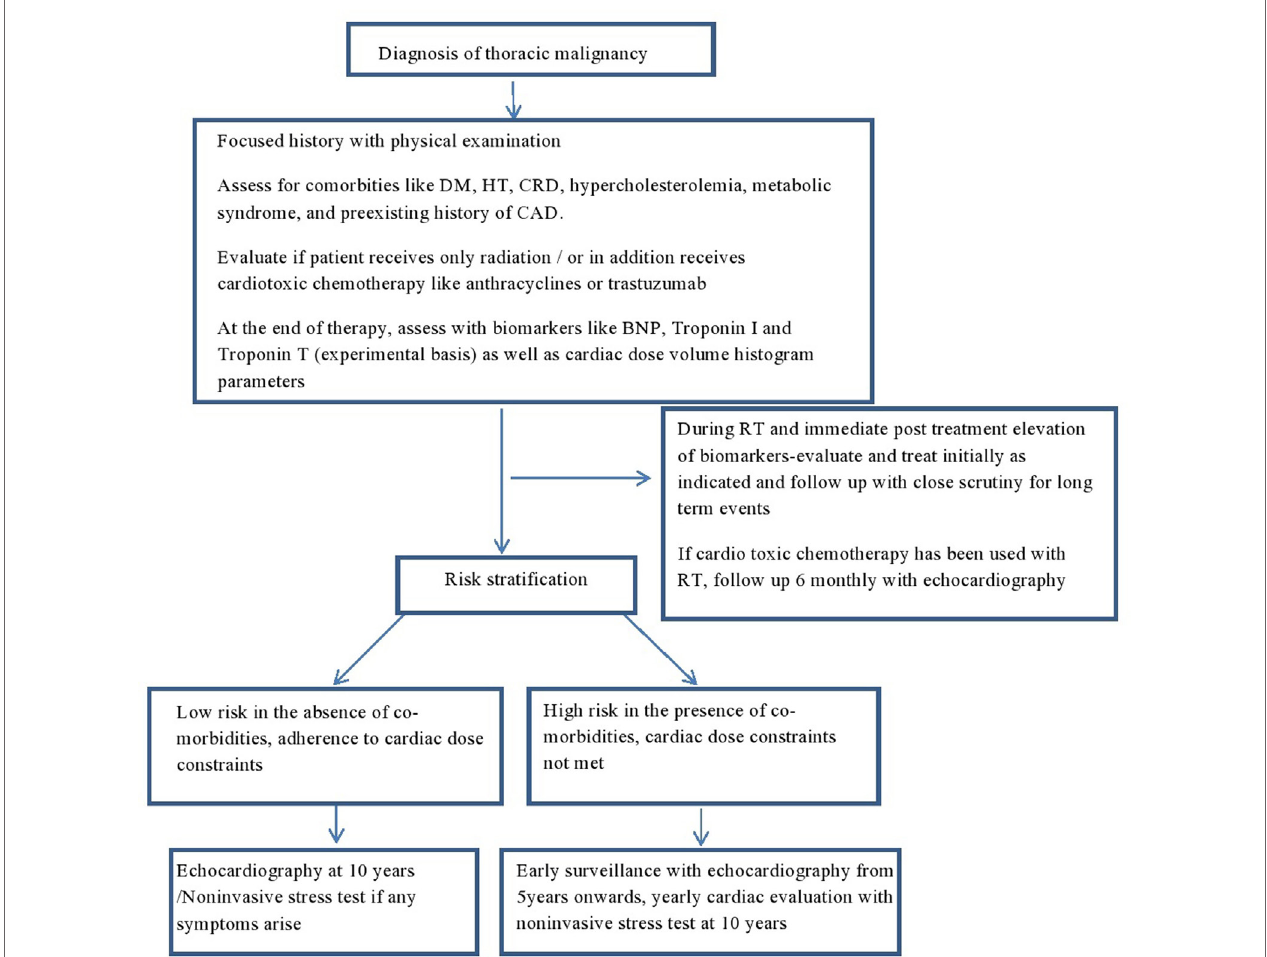
FigURe 2 | Proposed algorithm for follow-up in irradiated patients with thoracic malignancies. DM, diabetes mellitus; HT, hypertension; CRD, chronic renal disease; CAD, coronary artery disease; BNP, brain natriuretic peptide; TnI, troponin I; TnT, troponin T; RT, radiation.